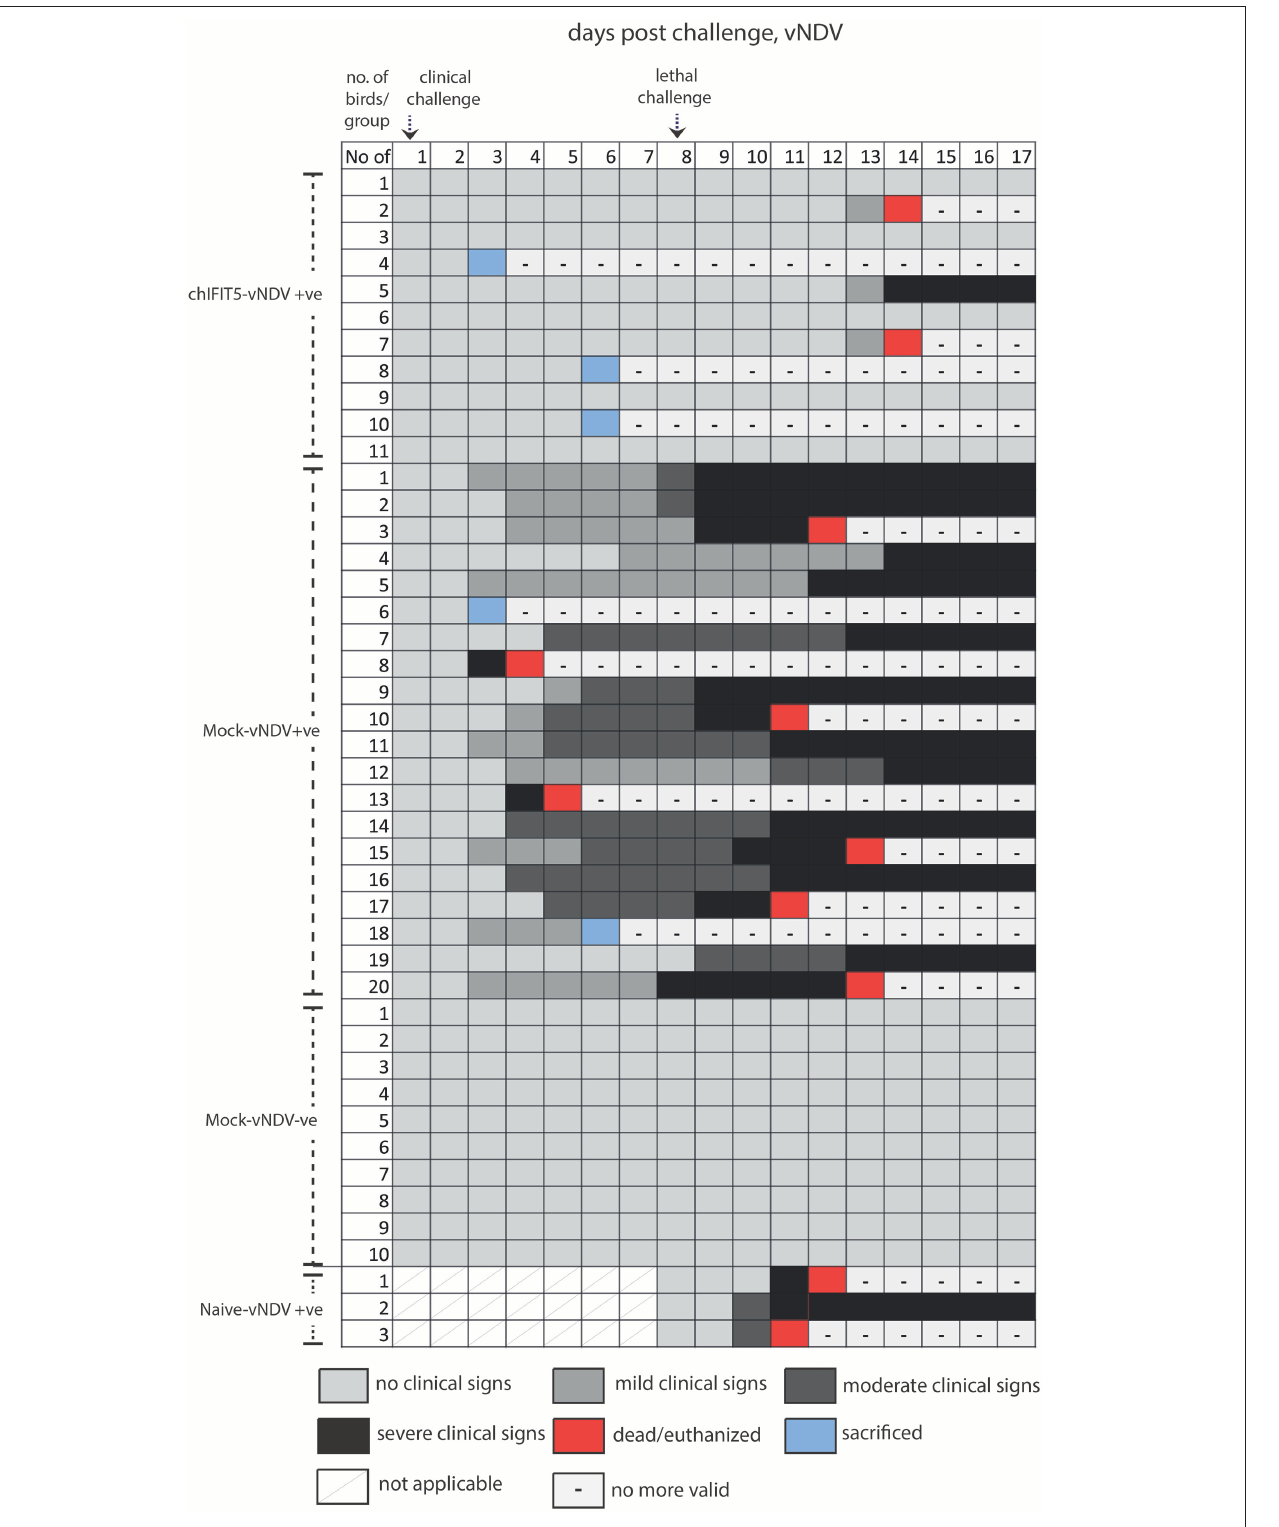
FIGURE 5 | Clinical signs of individual chicken in different groups pre- and post-clinical and lethal challenge induced by the vNDV.